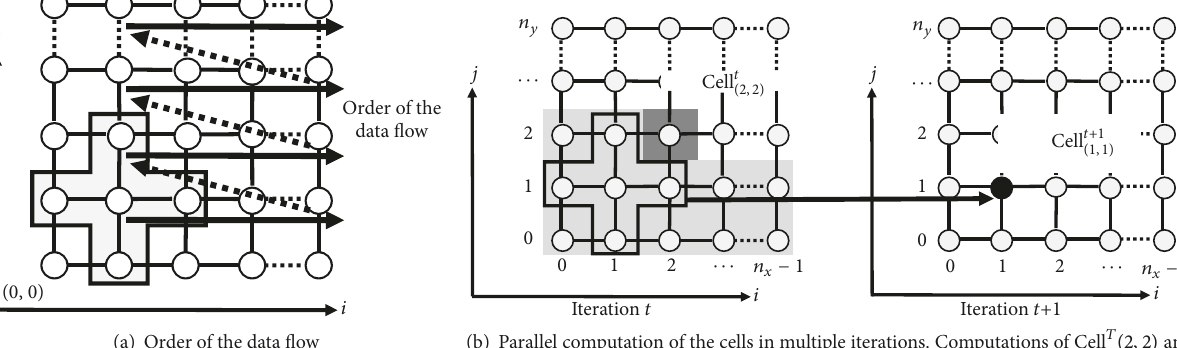
Figure 1: 2D stencil computation using 𝑛 𝑥 × 𝑛 𝑦 grid. Iterations 𝑡 and 𝑡 + 1 are computed in parallel.